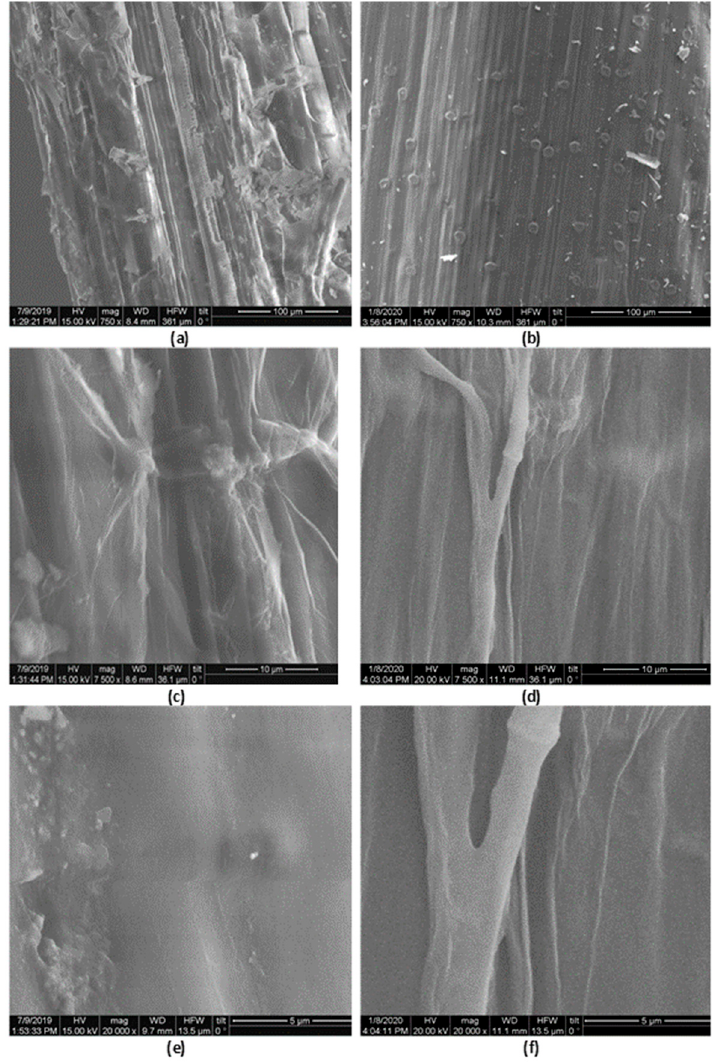
Figure 8. Scanning Electron Microscopy (SEM) images of untreated barley straw at ( a ) × 750, ( c ) × 7500 and ( e ) × 20,000 magnification, and torrefied barley straw at ( b ) × 750, ( d ) × 7500 and ( f ) × 20,000 magnification.